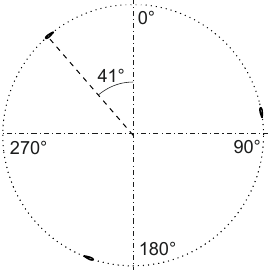
Figure 3. Illustrative drawing of the turbine from above. The blade with the measurement equipment is located 41 ◦ from north.